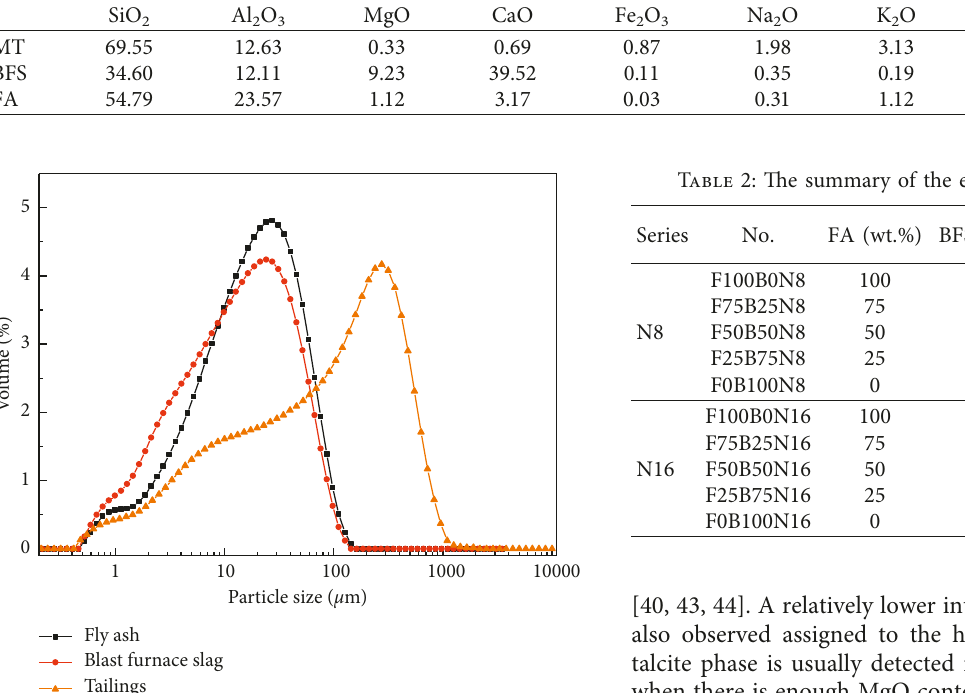
Table 1: Chemical composition (wt.%) and physical property of MT, BFS, and FA.